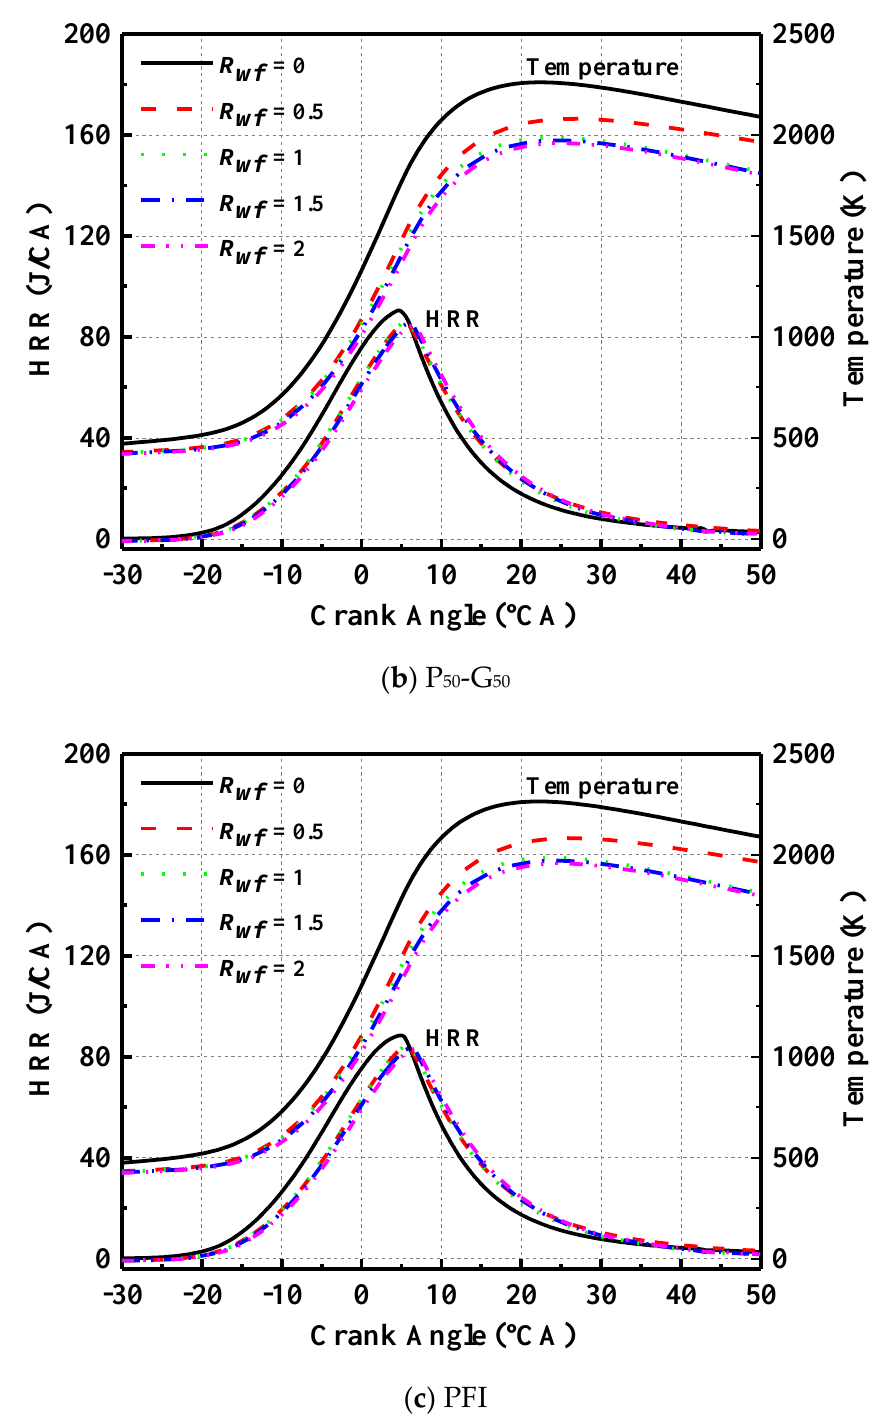
Figure 12. Effects of 𝑅 𝑤𝑓 on HRR and in-cylinder temperature.